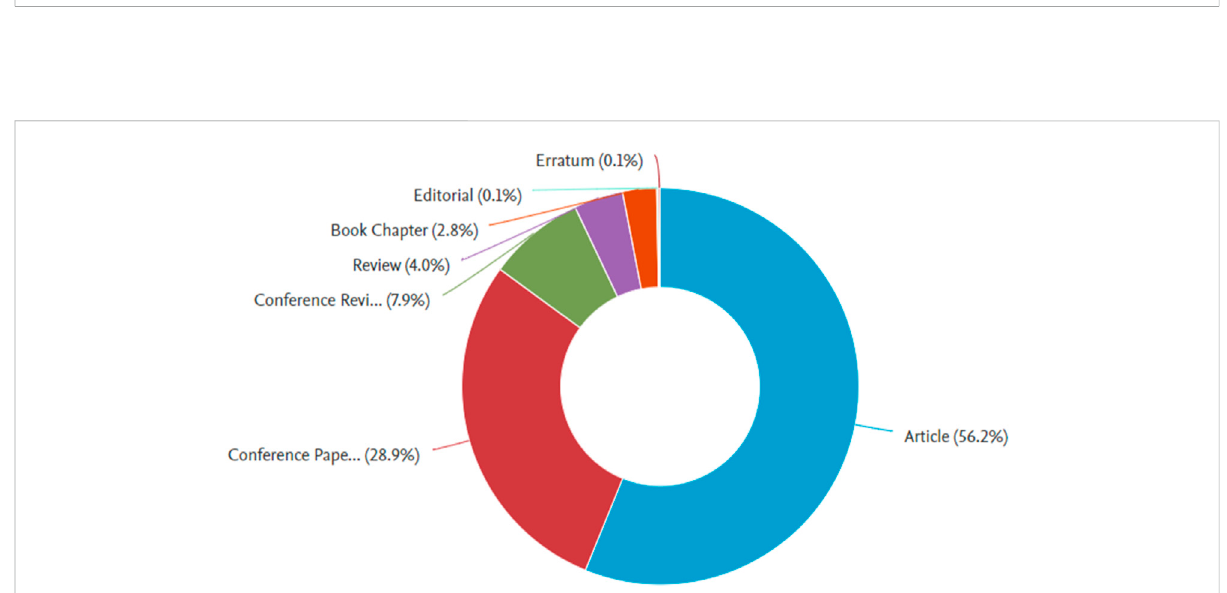
Domains of documents in mineral fi ber-reinforced concrete